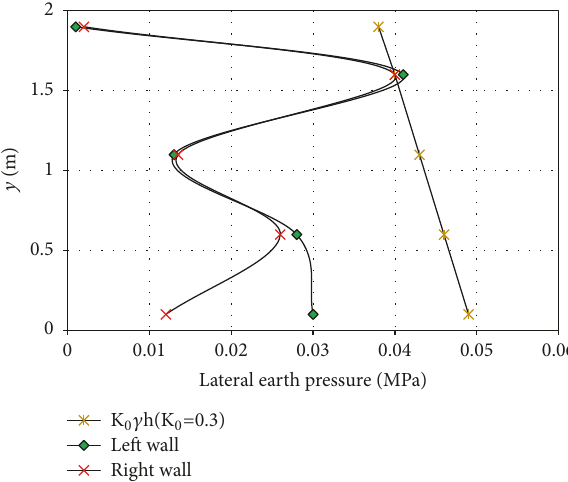
Figure 14: Lateral earth pressure on lateral wall under 7 m